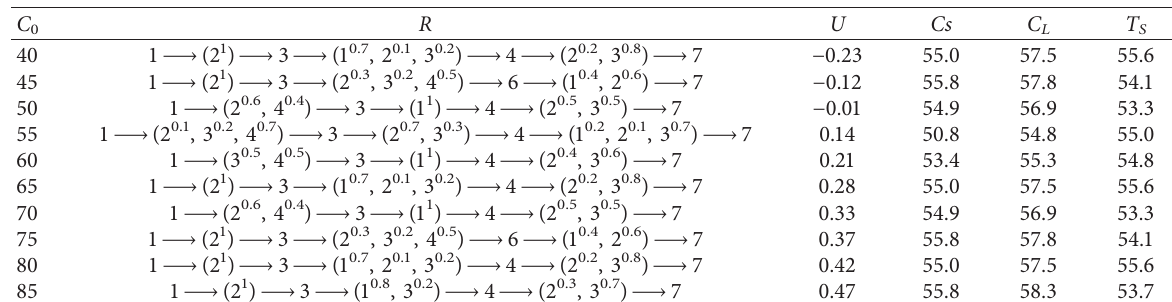
Table 6: The impact of C 0 on the transportation plans.